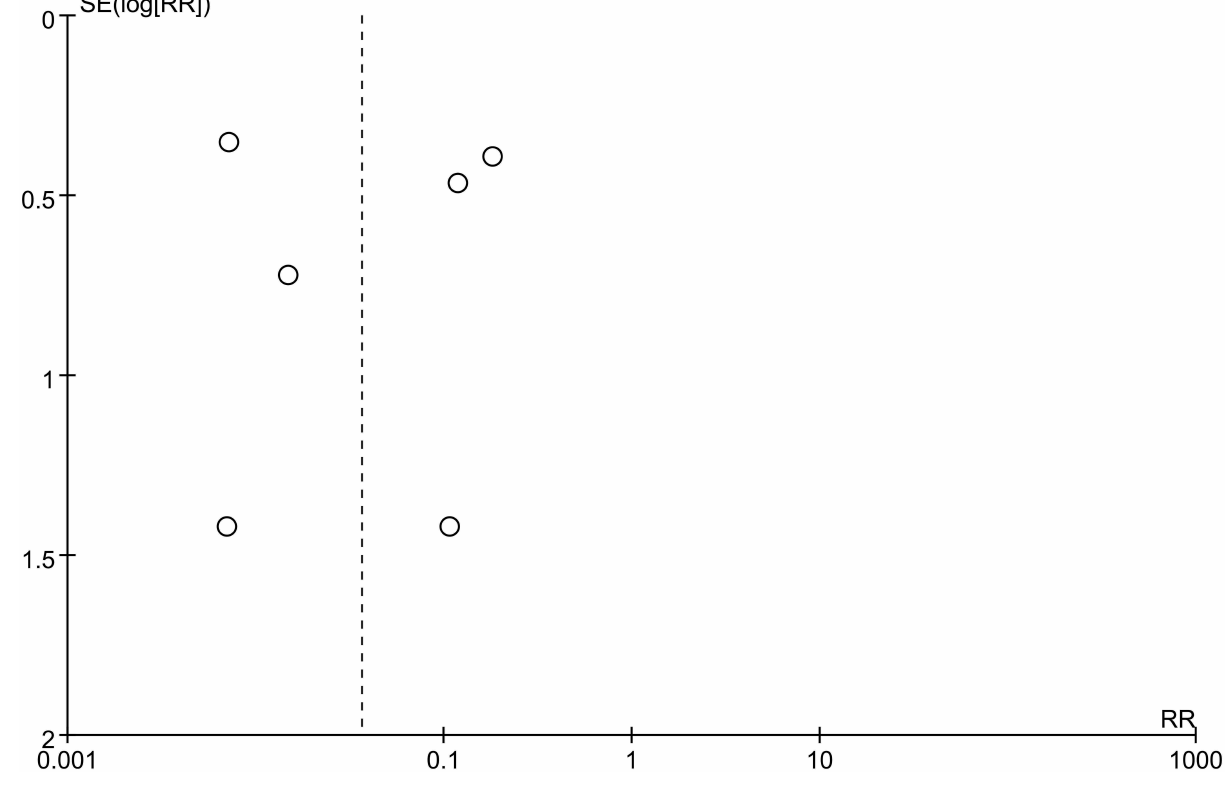
FIGURE 4 | Funnel plot of neurosurgery